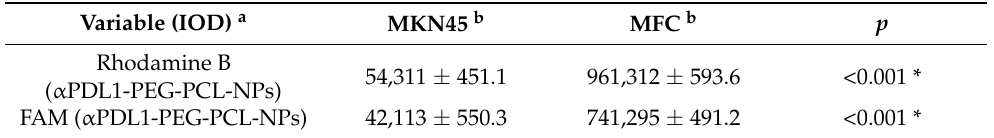
Table 3. Integrated optical density (IOD) values for DID-PEG-PCL-NPs and DID- α PD1-PEG-PCL- NPs in MFC and MKN45 cells.